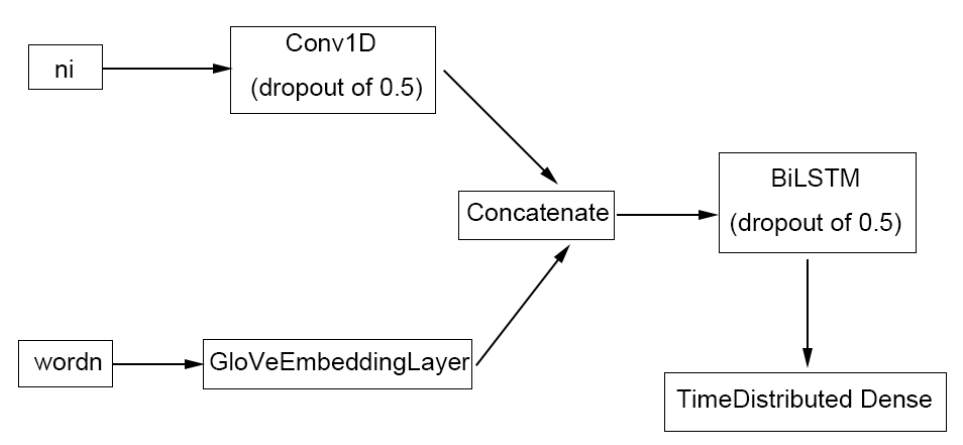
Figure 6. The architecture of the ChemListem network. The input tensors ‘wordn’ and ‘ni’ correspond to the numerical representations of word (token) sequences and the name-internal features of word (token) sequence determined by the pre-classifier,